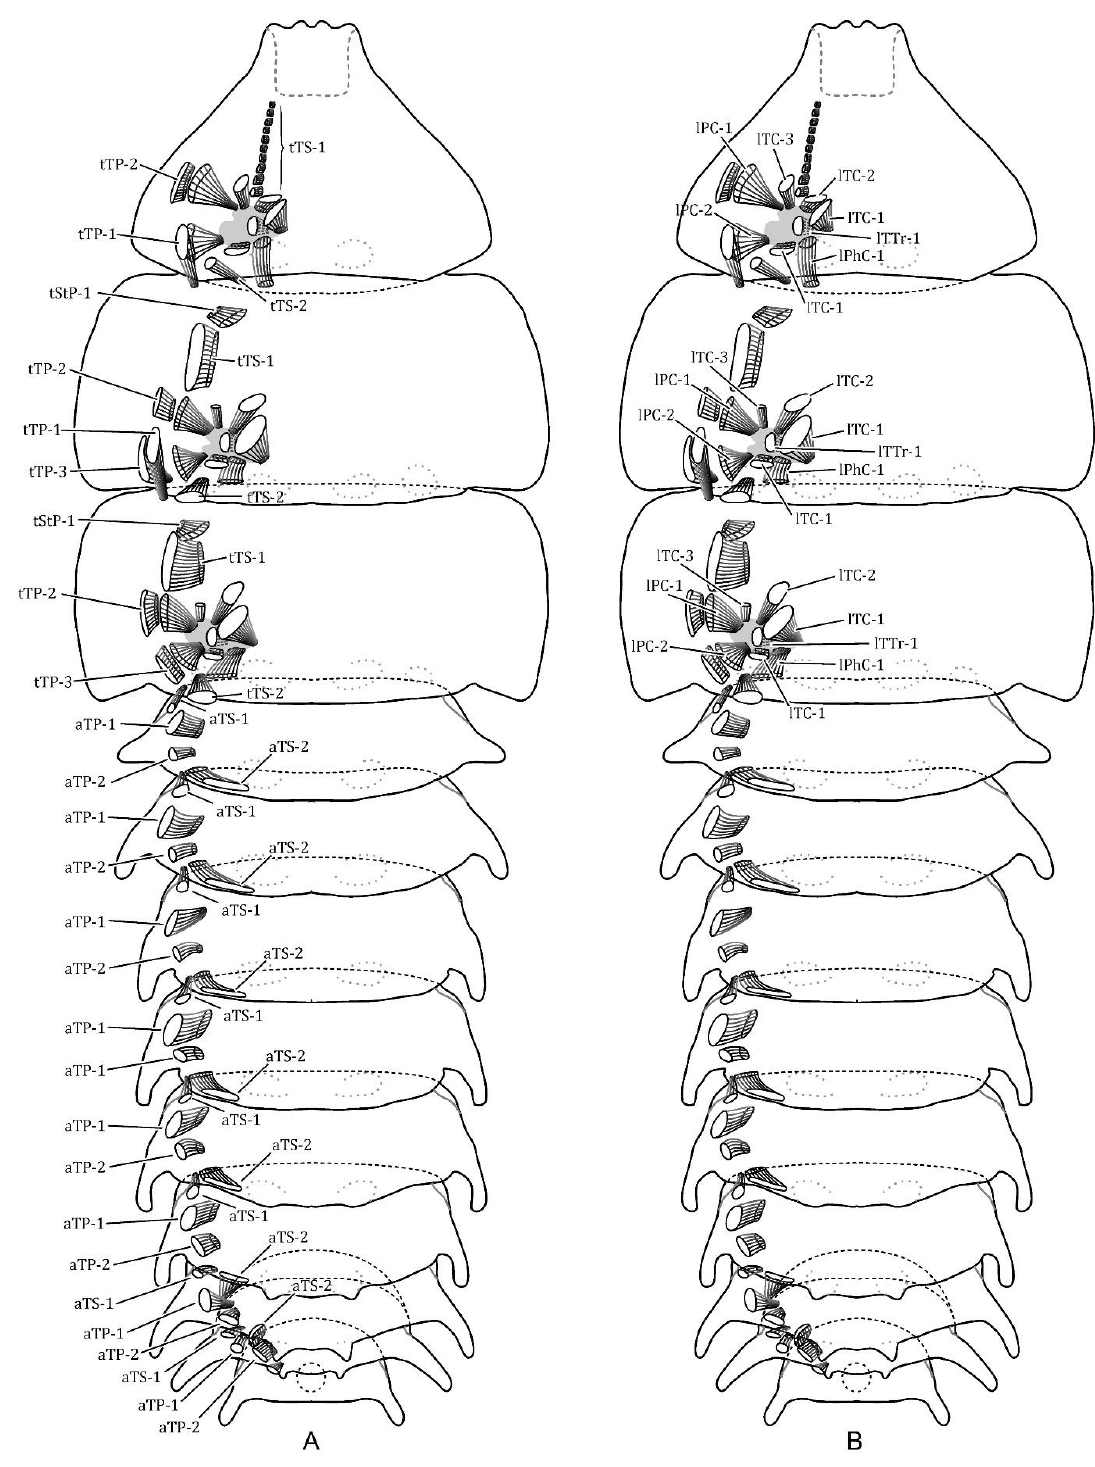
Figure 10. Platerodrilus svetae , female. ( A )—dorsoventral and tergo-pleural muscles; ( B )—tergo-coxal, pleuro-coxal and sterno-coxal muscles. Explanations in text. Leg (Figure 11). Muscles of the leg originating on the tergite and pleurite are described above in respective sections.